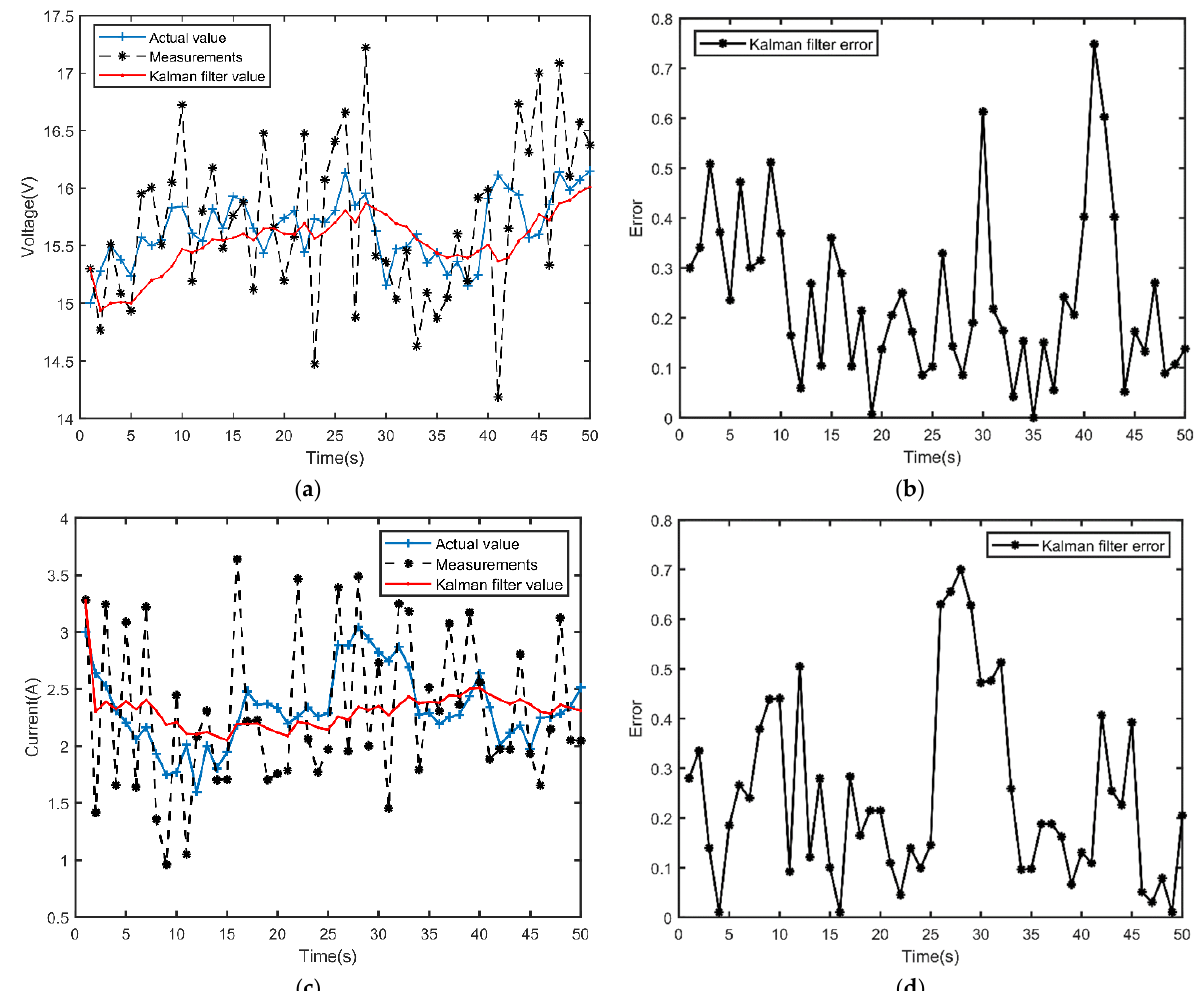
Figure 12. ( a ) Results of Kalman filtering algorithm for output voltage. ( b ) Error between the voltage filtered value and the real value. ( c ) Results of Kalman filtering algorithm for output current. ( d ) Error between the current filtered value and the real value.